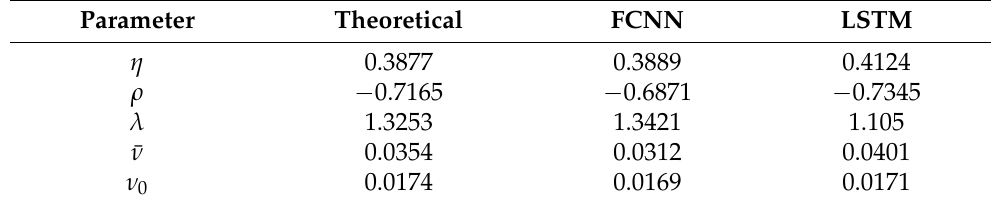
Table 2. Comparison between the theoretical parameters and the neural networks